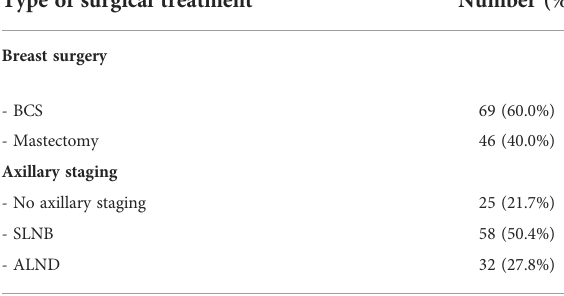
TABLE 2 Detailed surgical treatment of 115 patients with con fi rmed Paget ’ s